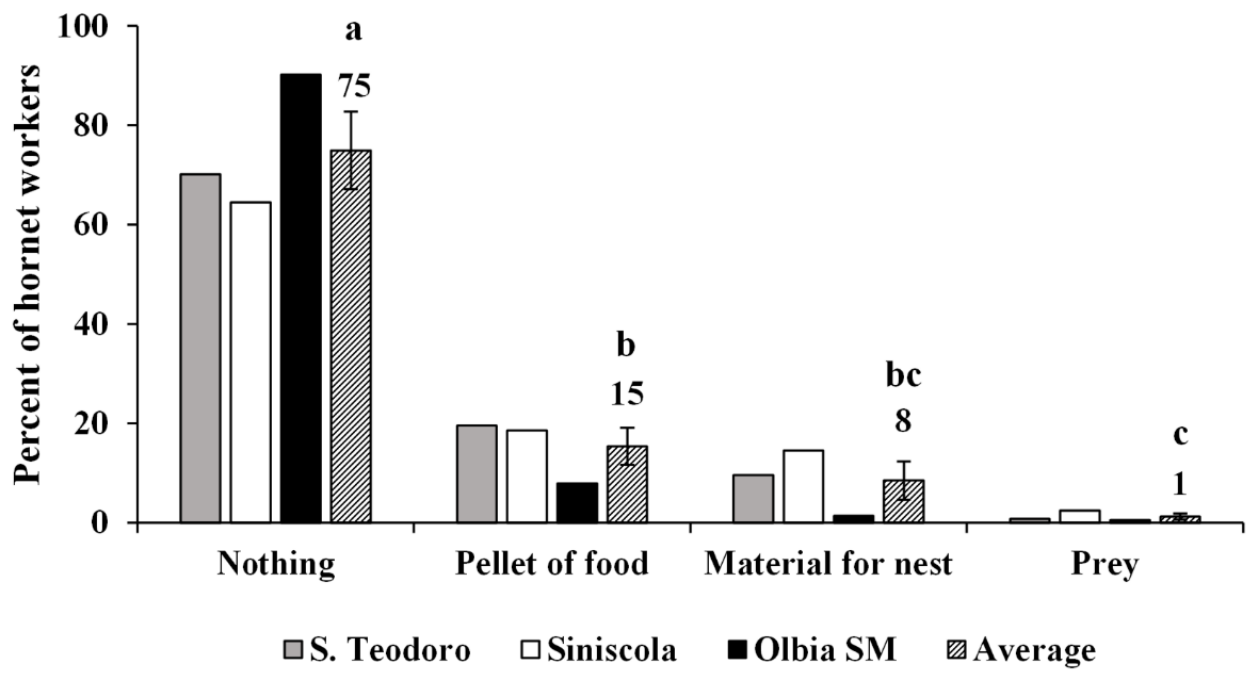
Figure 5. Relative frequency of European hornet workers entering the nest with nothing (possibly water or nectar), pellet of food, material for nest building, or prey between their mandibles in three nest sites. Different letters indicate significant differences among payloads ( p <